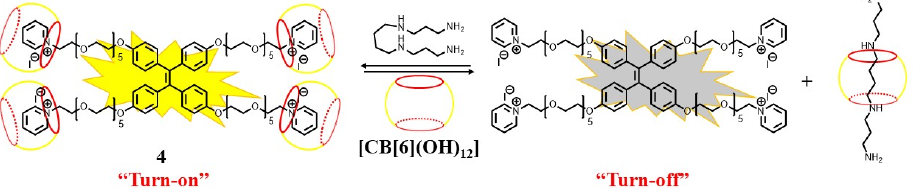
Figure 5. Schematic r epresentation of the three ‐ component supramolecular sensing assay for spermine (and spermidine) [47]. mine (and spermidine)